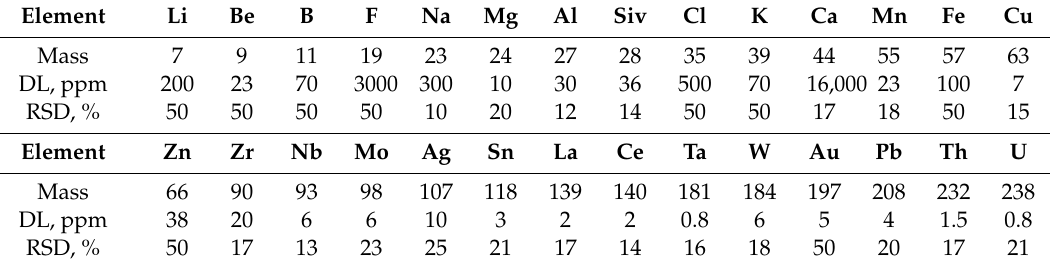
Table 1. Detection limits of LA-ICP-MS analysis.